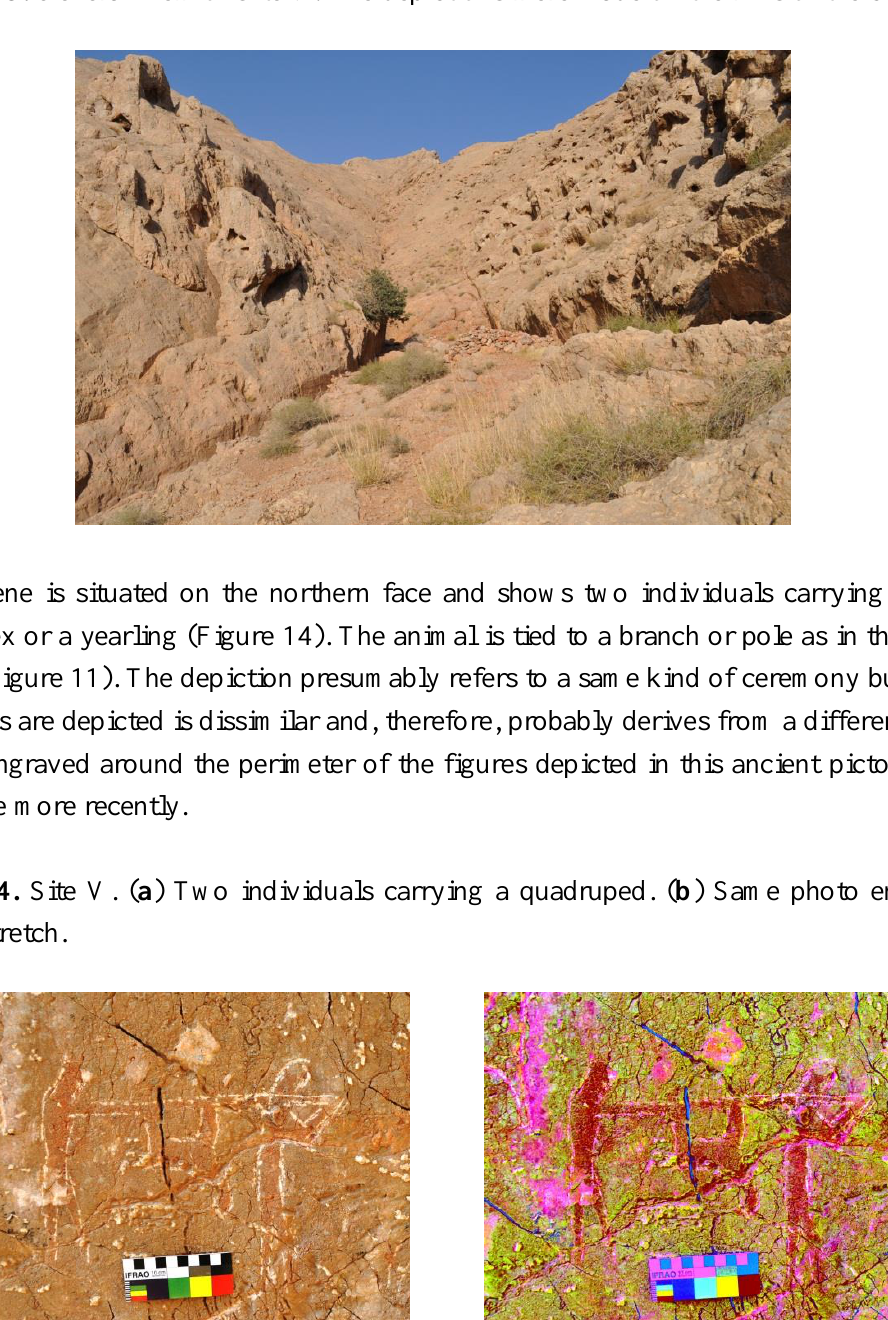
Figure 13. General view of Site V. The depictions were made on the rims of the channel.